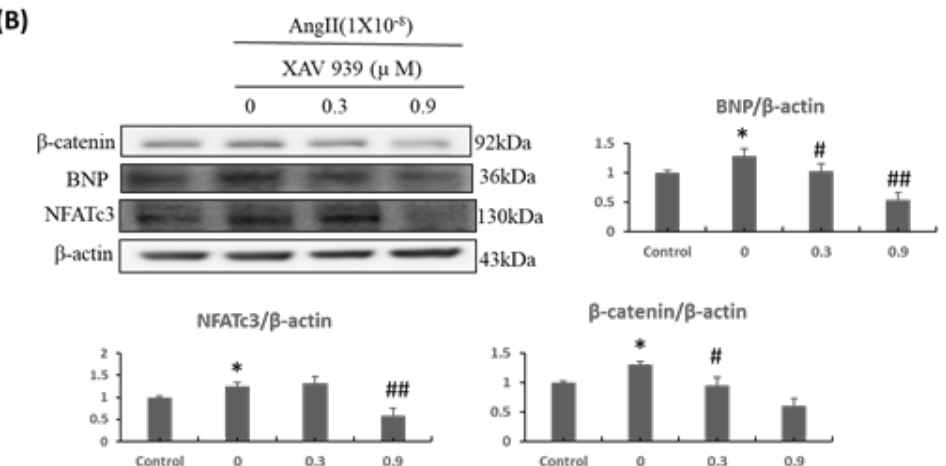
Figure 1. Effect of Ang-II treatment on endogenous β-catenin levels and hypertrophy associated protein markers in H9c2 cardiomyoblast cells. ( A ) H9c2 cells were treated with increasing concentrations of Ang-II and incubated for 24 h. At the end of the incubation period, cells were harvested, protein extracted, and subjected to western blot (WB) analysis. β-catenin and IGF-IIR expression were assessed along with downstream cardiac hypertrophy associated protein markers. ( B ) Following above experiment, 100 nM Ang-II treatments were selected for further experimental usage. H9c2 cells were subjected to Ang-II treatment with incubation for 24 h, followed by treatment with β -catenin inhibitor XAV 939 at increasing concentrations (0.3 µ M, 0.9 µ M, respectively) for another 12 h. At the end of 36 h, cells were harvested, protein extracted, and WB analysis was performed. Fold with respect to untreated controls have been shown in graphs. p * < 0.05, # < 0.05, ## <